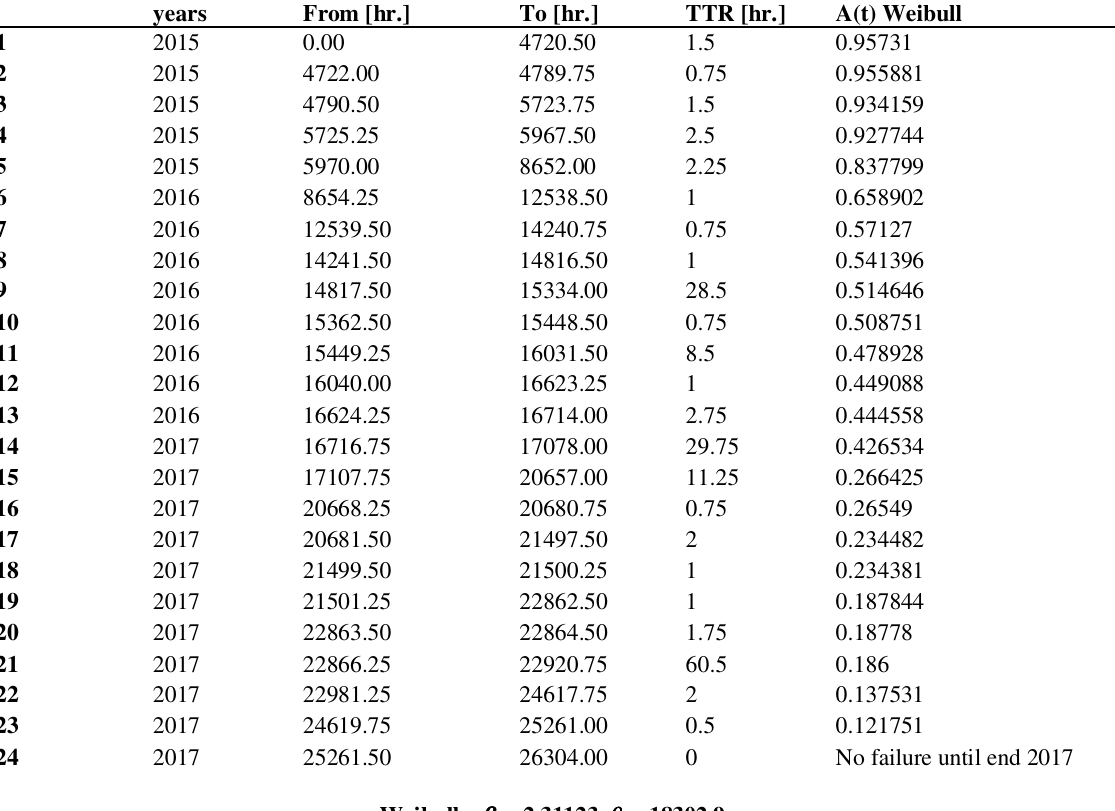
Availability of Generator for the years (2015-2017) by Minitab17 software. years From [hr.] To